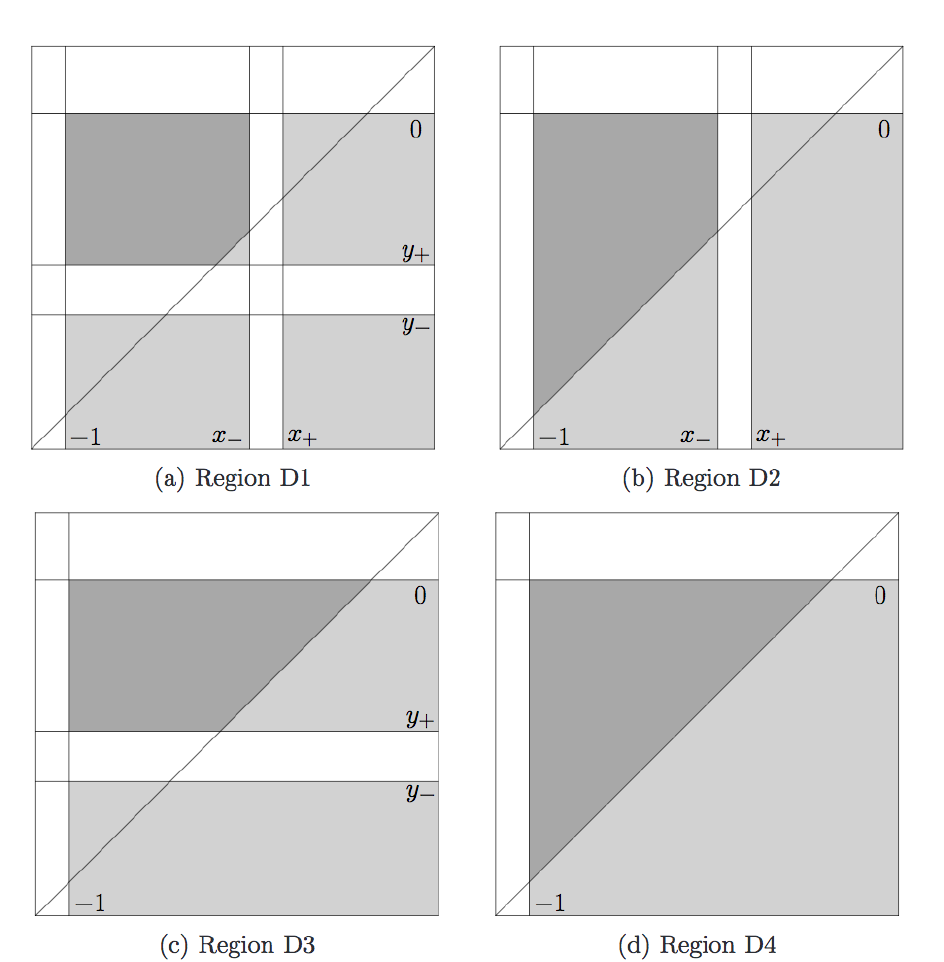
Figure 3 . The range of x; y coordinates. Shaded areas correspond to the coordinate ranges with Lorentz signature. Darker shaded regions are of most interest. Figure reproduced with permission from Teo et al.